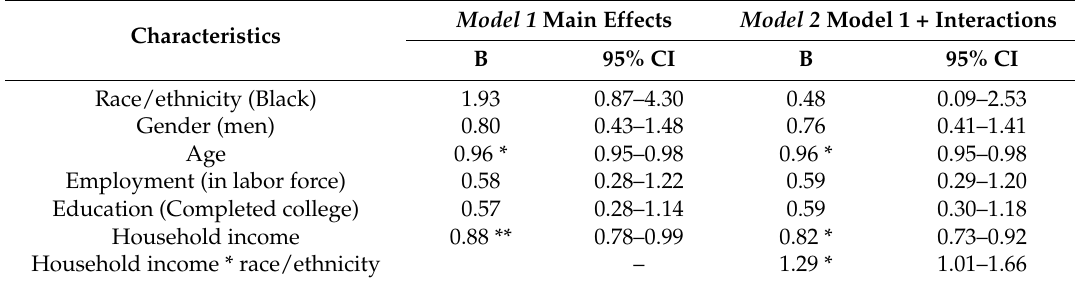
Table 3. Summary of logistic regressions between household income and poor SRMH in the pooled